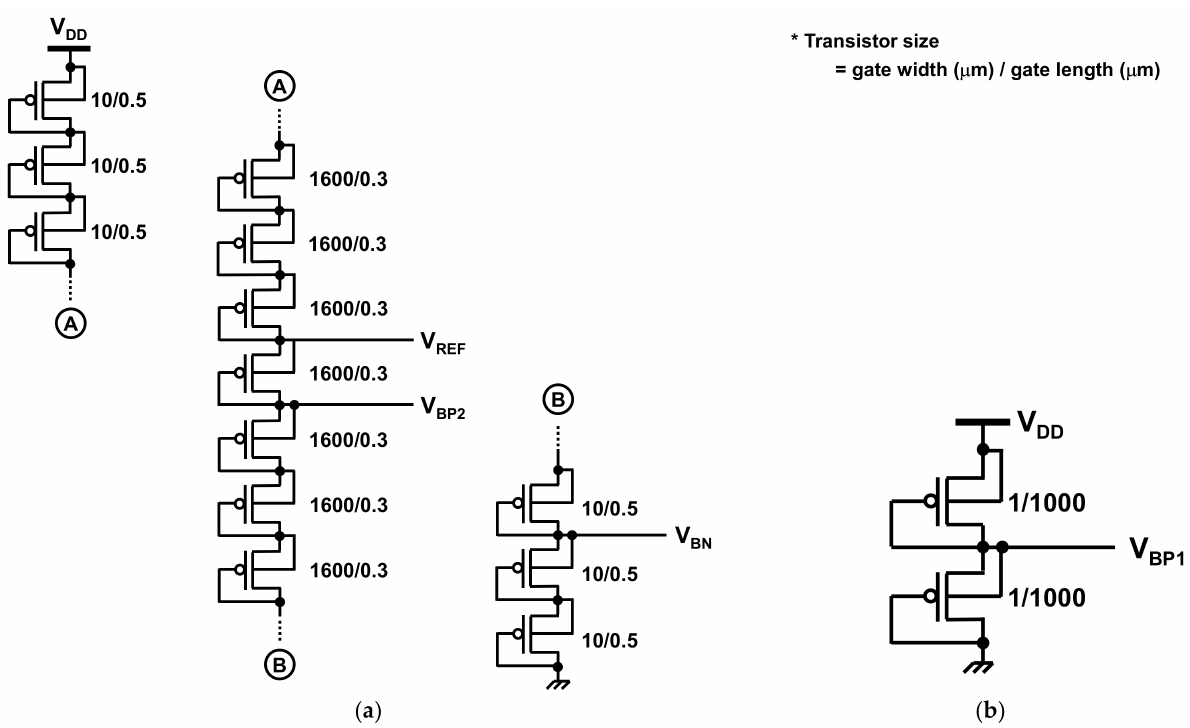
Figure 8. ( a , b ) Circuit schematic of the bias voltage generator. This circuit generates the four bias voltages; V BP1 and V BP2 are used in the front-end amplifier (Figure 4), whereas V REF and V BN are used in the comparator (Figure